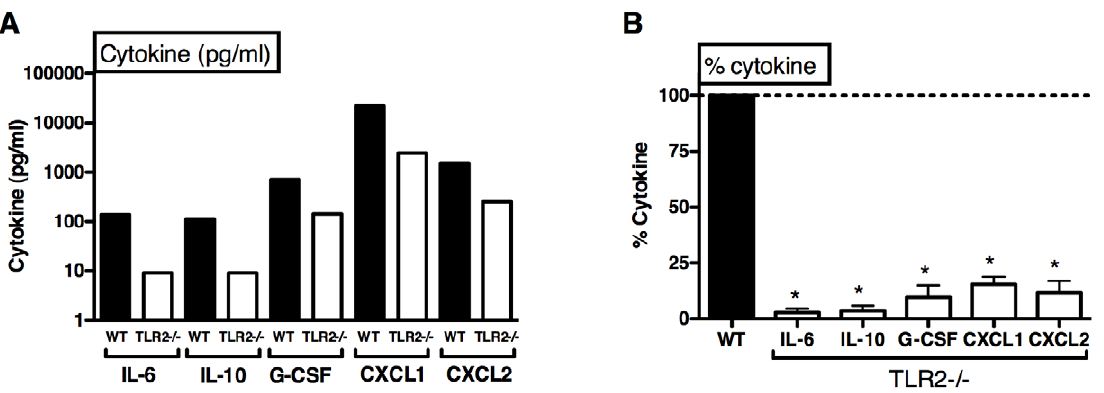
Figure 5. SE-induced cytokine production is TLR2-dependent invivo . Female C57BL/6 WT or TLR2-deficient mice were injected intravenously with 10 8 CFU SE prior to collection of peripheral blood at 1 h for measurement of cytokines/chemokines by using multi-analyte flurometric beads as described in Methods. (A) SE-induced production of cytokines/chemokines is lower in TLR2-deficient mice (representative of 3 similar experiments). (B) Composite analysis demonstrating % cytokine production of TLR2-deficient mice relative to WT (n=3, one-sample t-test versus 100%). *p , 0.05.